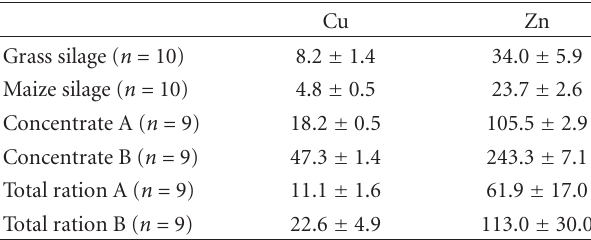
Table 2: Mean copper and zinc contents of the di ff erent feed components (mg/kg DM).